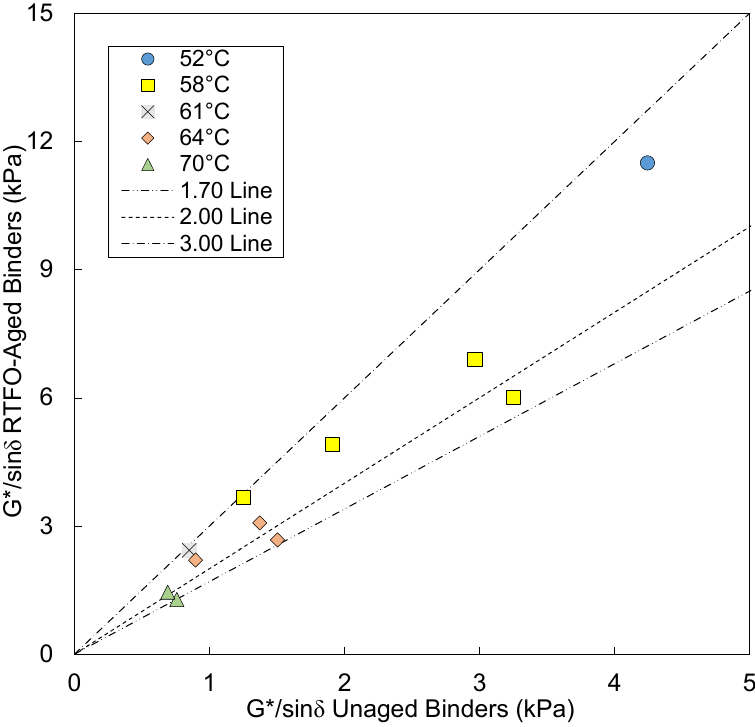
Figure 5. Rutting Factors of Unaged and RTFO-aged Binders at Different Temperatures.